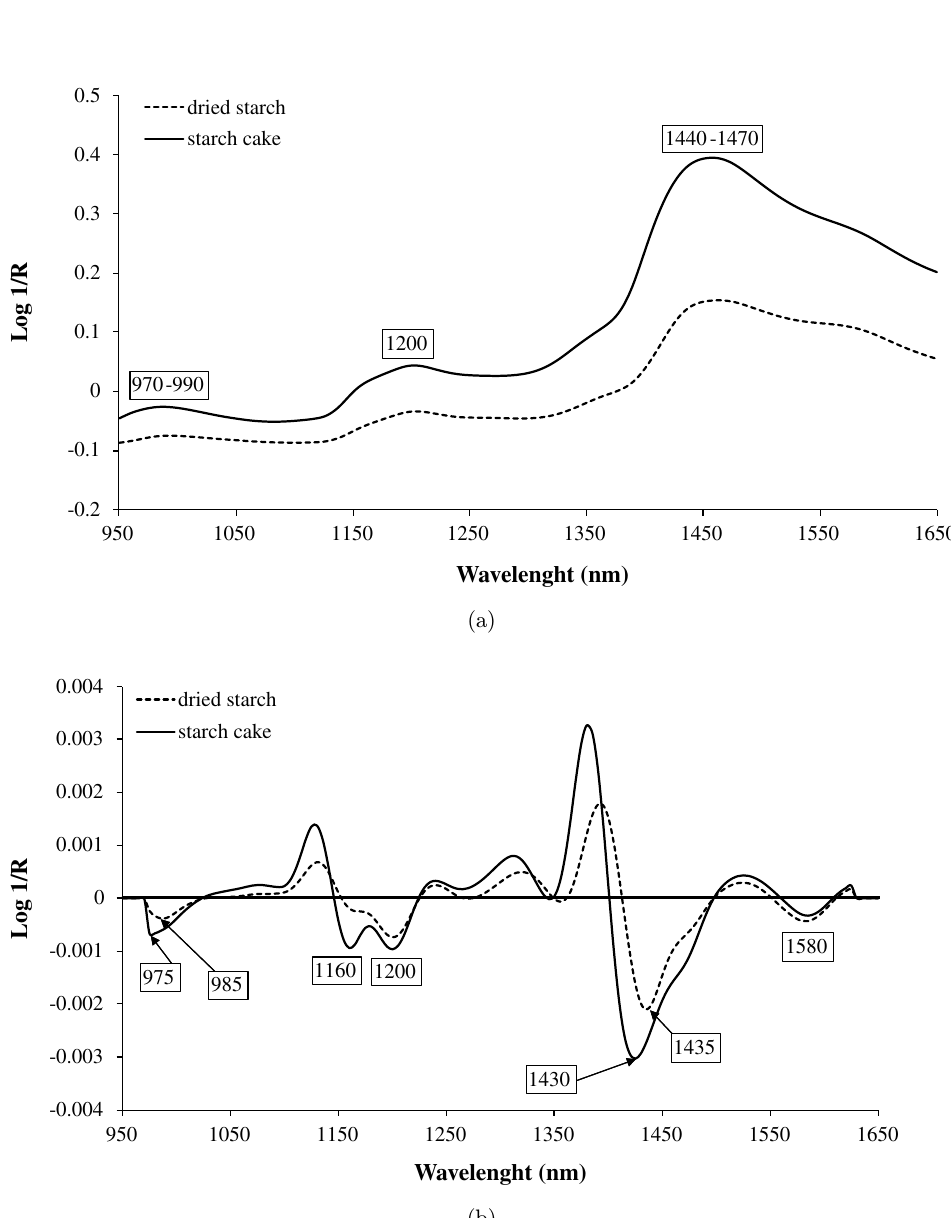
Fig. 1. Averaged NIR spectra of tapioca starch cake and dried tapioca starch. (a) Average raw absorbance spectra. (b) Average second derivative spectra (11 points).